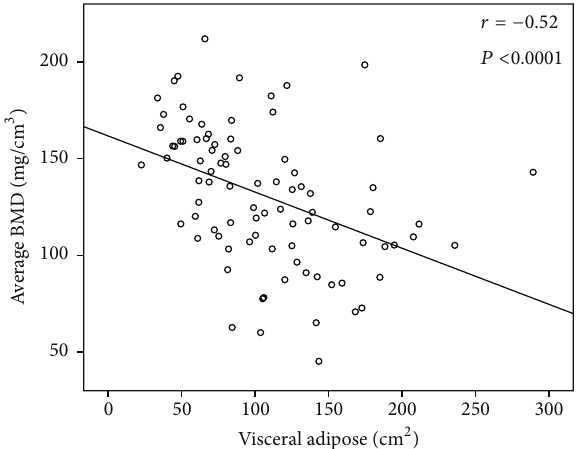
Figure 1: Correlation between average bone mineral density (mg/cm 3 ) and visceral adipose tissue in group aged < 55. “ 𝑟 ” is the Spearman correlation coefficient.